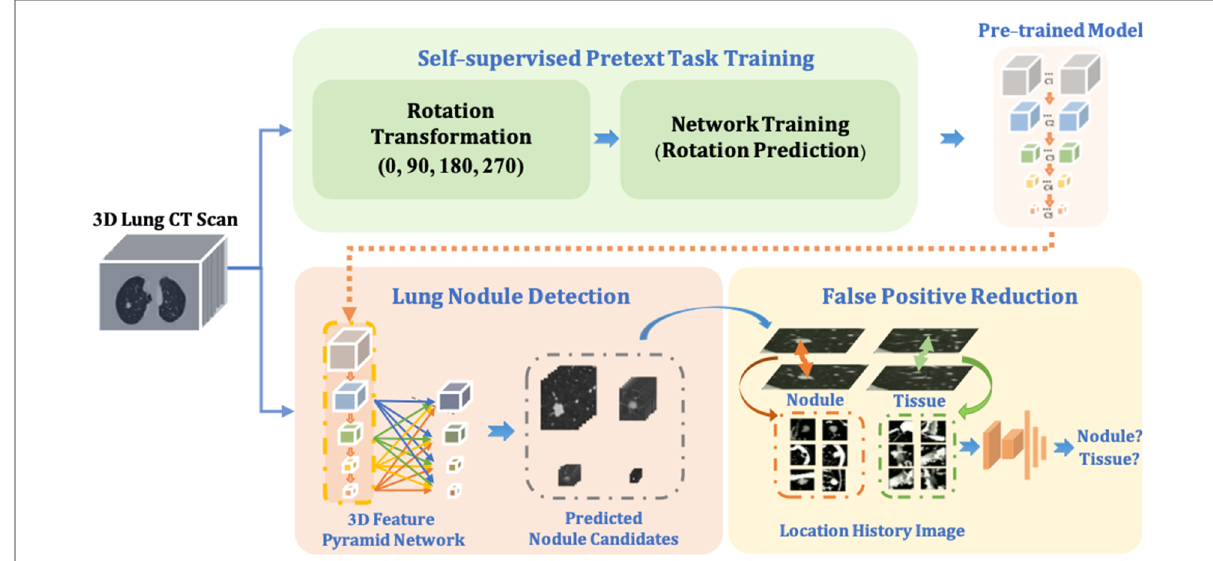
FIGURE 1 The proposed robust nodule detection framework 3DFPN-HS 2 consists of 3D Feature Pyramid ConvNet ( 3DFPN ) as lung nodule detector and HS 2 as false positive reduction network for high sensitivity and speci fi city lung nodule detection. (1) To improve the robustness of the framework across different datasets, a pre-trained model trained on the backbone network of detector ResNet-18 is applied to the nodule detection network. The pre-trained model is obtained by a simple yet effective pretext task training through a rotation prediction network. The original CTs are rotated through a geometric transformation at (0, 90, 180, 270) degrees and followed by a classi fi cation network to predict the rotated angles of CT scans. (2) The 3DFPN takes the input of the entire CT scan to predict nodule candidates. The backbone network ( ResNet-18 ) of 3DFPN is initialized by the weights from the pretrained model and then is fi ne-tuned with small datasets with annotation for pulmonary nodule detection in a supervised schema. (3) For the detected nodule candidates, the HS 2 network eliminates the false prediction of normal tissues based on the change in position of the continuous CT slices on LHI images. The detailed structure of self-supervised pretext task training is shown in Figure 2 , the proposed 3DFPN network can be found in Figure 3 , and LHI is illustrated in Figure 4